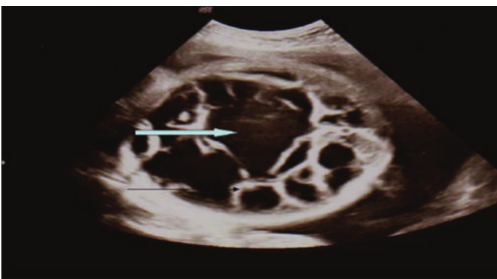
Figure 1: Antenatal ultrasound scan view showing the foetal abdomen and revealed the presence of a large cystic lesion with multiple thick septation (black arrow) containing fluid and fine echoes (block arrow).